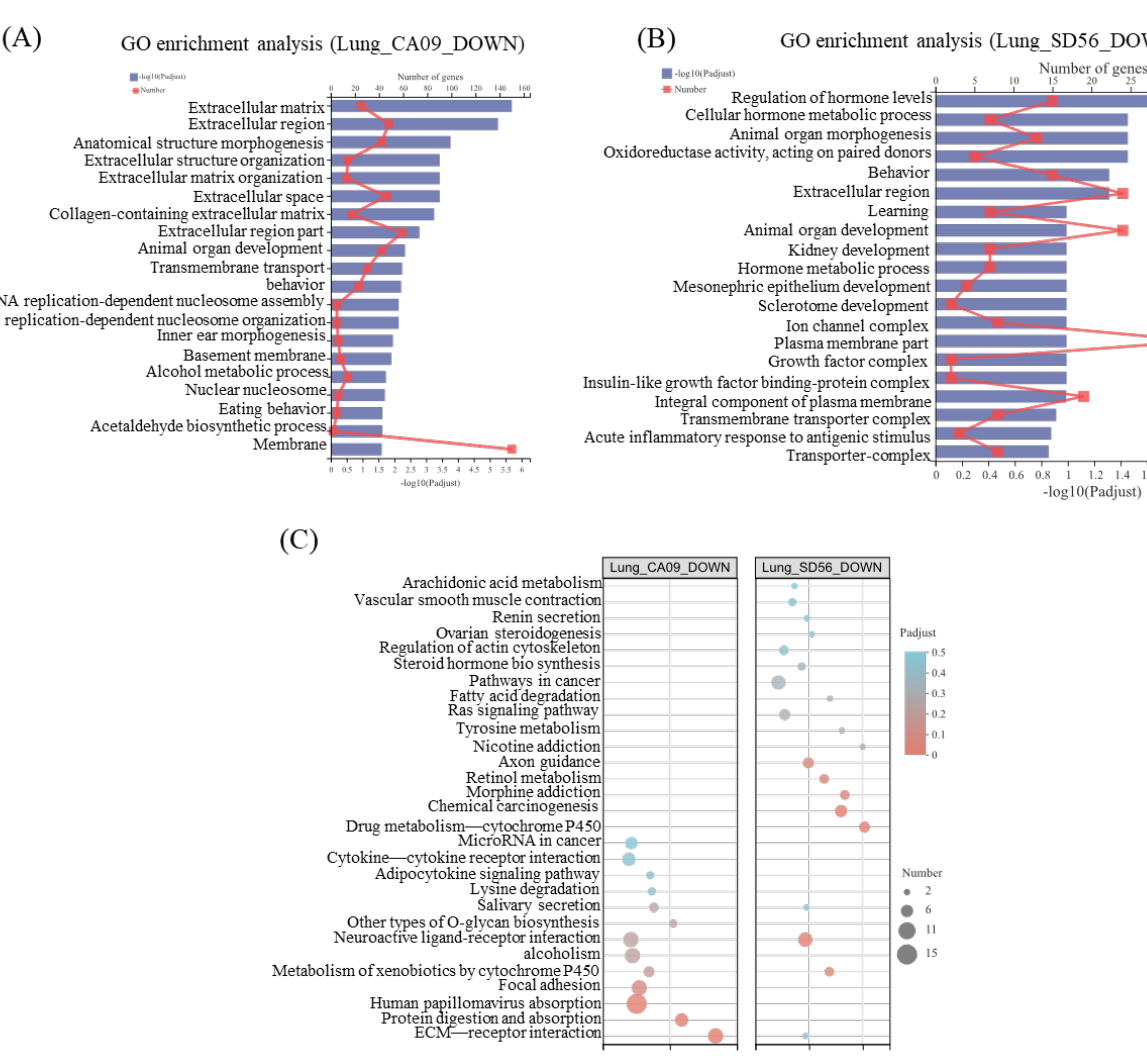
Figure 5. GO and KEGG functional enrichment of downregulated genes in mice lungs. ( A ) GO enrichment analysis of uniquely downregulated lung genes in CA09 relative to the control; ( B ) GO enrichment analysis of uniquely downregulated lung genes in SD56 relative to the control; ( C ) KEGG enrichment bubble diagram of uniquely downregulated lung genes in SD56 relative to the control (left) and in CA09 relative to the control (right). Circles indicate numbers of genes and colors depict the richness